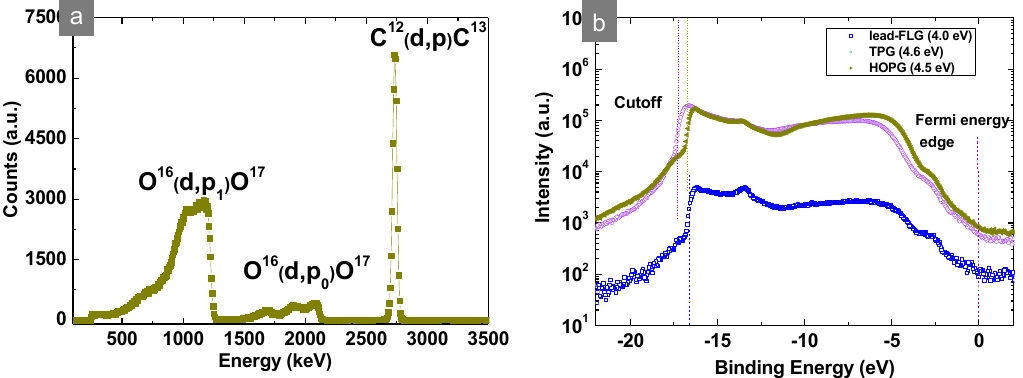
Figure 5. ( a ) Nuclear Reaction Analysis (NRA) spectra obtained for the graphite-FLG film (electrode) with carbon 12 C at 2770 keV and ( b ) UPS work functions of lead- and graphite-FLG samples. Because of the resolution of NRA analysis (up to a few µ m), the depth profile included the FLG film and SiO 2 substrate displaying two oxygen peaks for the two reactions. It was calculated